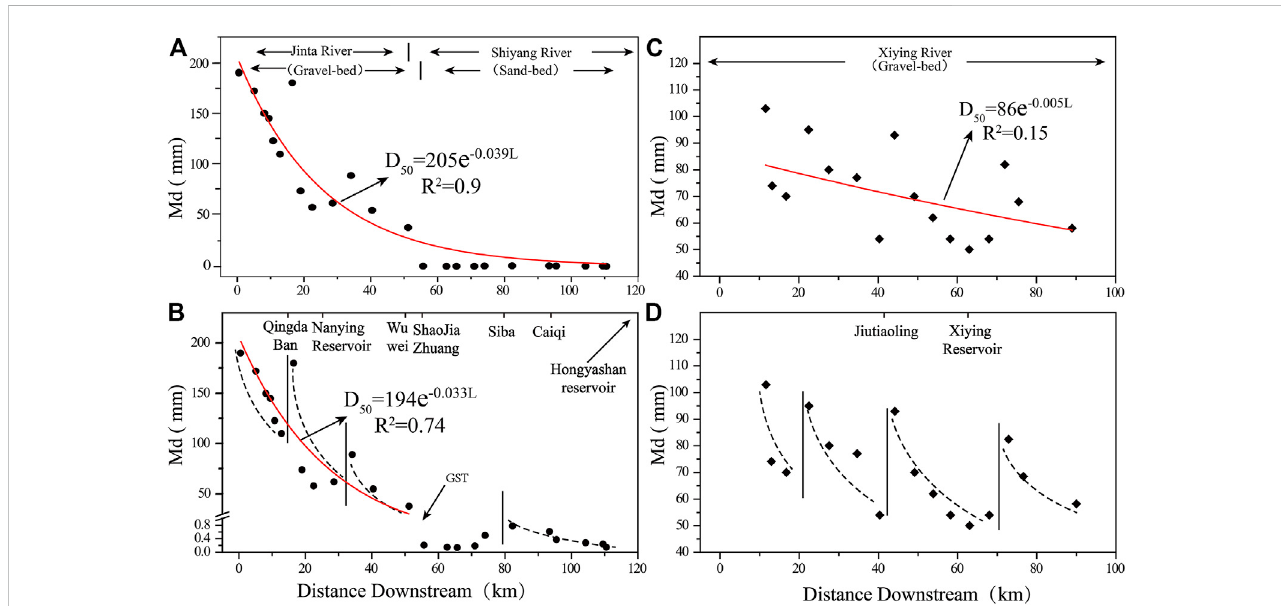
FIGURE 3 The variation characteristics of Md in channel sediments along the channel; (A,B) : The variation of Md along Jinta - Shiyang River. (C,D) : The variation of Md along Xiying River. The black solid line is the demarcation of the phase change, and the black dashed line is the general trend. Red solid line is the fi tting